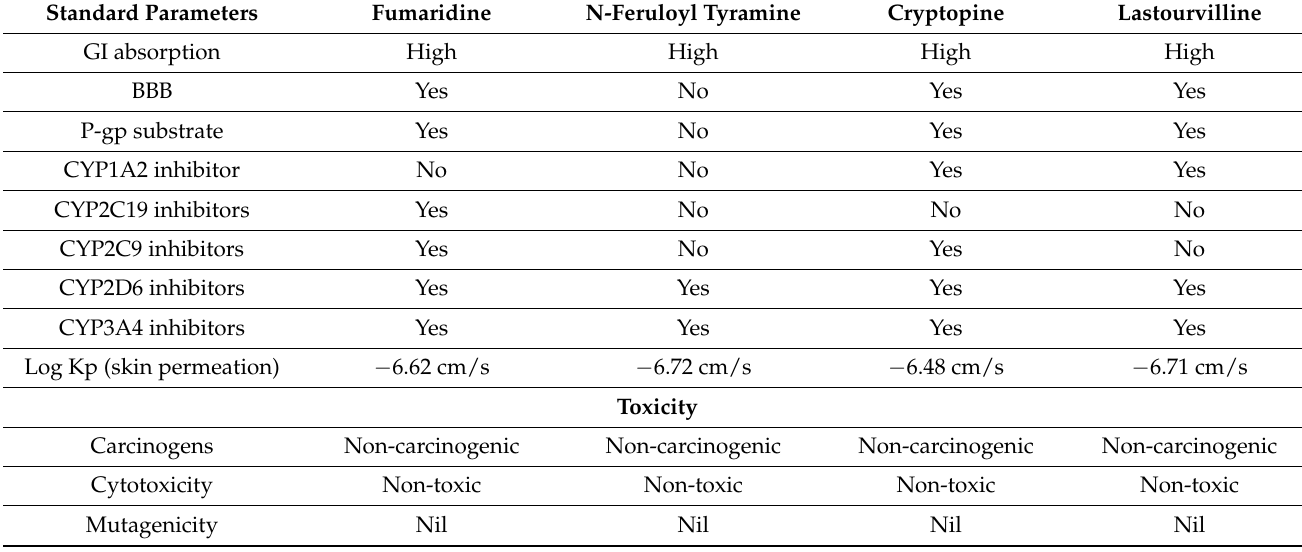
Table 5. ADMET profiling of